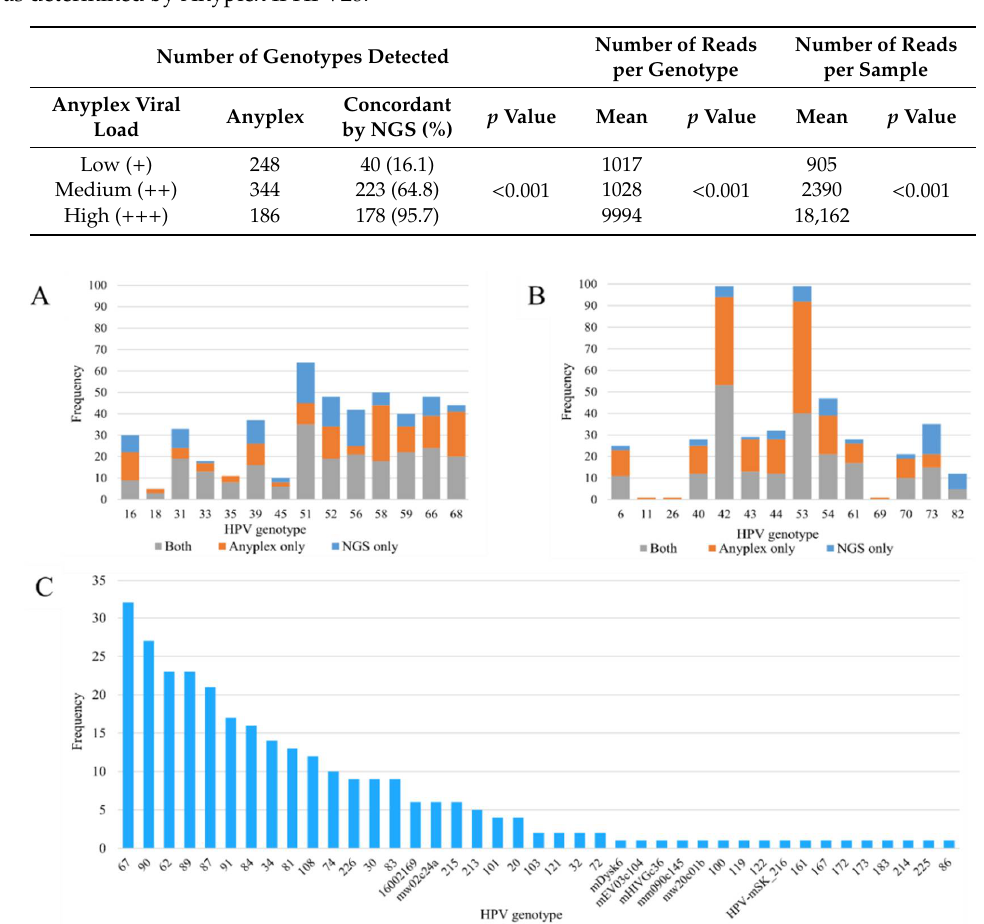
Figure 1. ( A , B ) Frequency distribution of human papillomavirus (HPV) genotypes detected by Anyplex II HPV28 and next-generation sequencing: ( A ) high-risk genotypes, ( B ) low-risk genotypes. Grey bars indicate genotypes detected by both methods, orange bars indicate genotypes detected by Anyplex II HPV28 only, and blue bars indicate genotypes detected by next-generation sequencing only. ( C ) Frequency distribution of HPV genotypes detected by next-generation sequencing only.